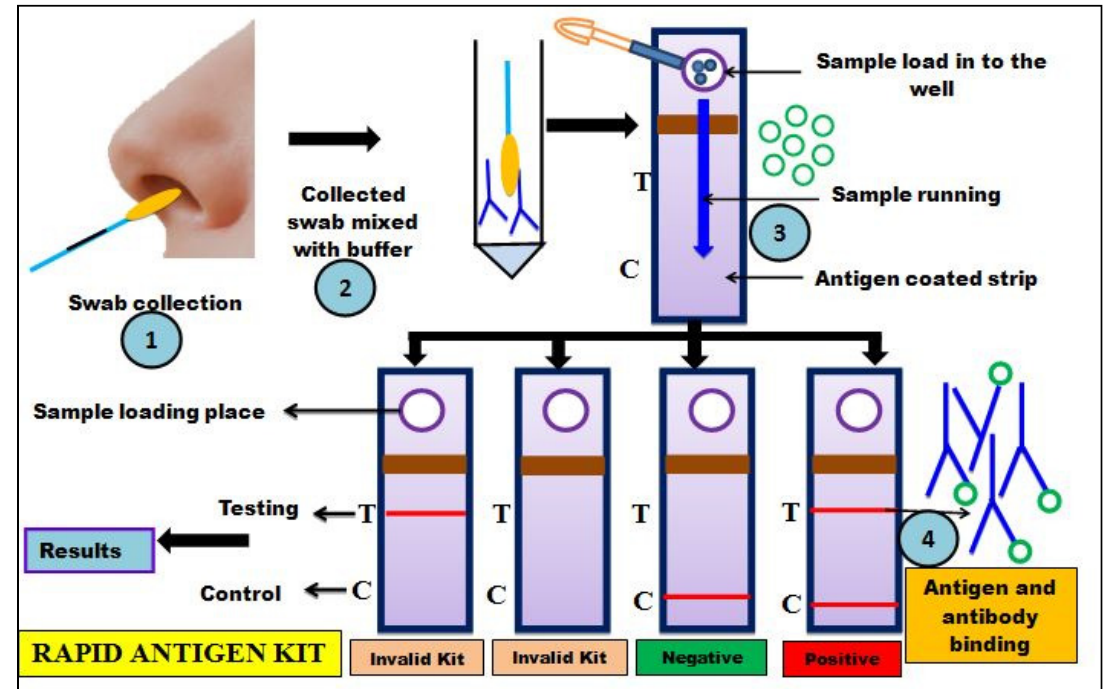
Figure 7. Rapid antigen test (RAT) kit-based detection of SARS-CoV-2 infection: ( 1 ) test samples are collected in the form of swabs; ( 2 ) mixing the collected swab samples with buffer; ( 3 ) loading collected sample into the well of the antigen-coated strip; ( 4 ) formation of one band representsa negative test, and two bands represent a positive test for COVID-19 infection.